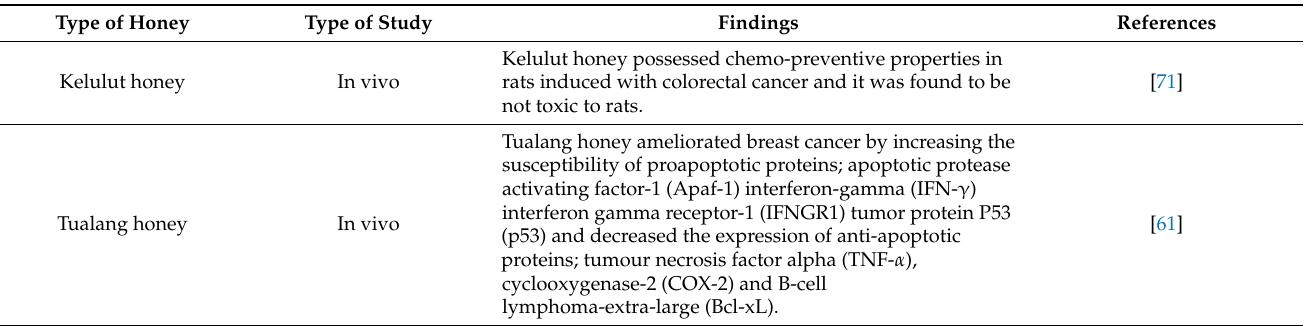
Table 4. Summary of anti-cancer